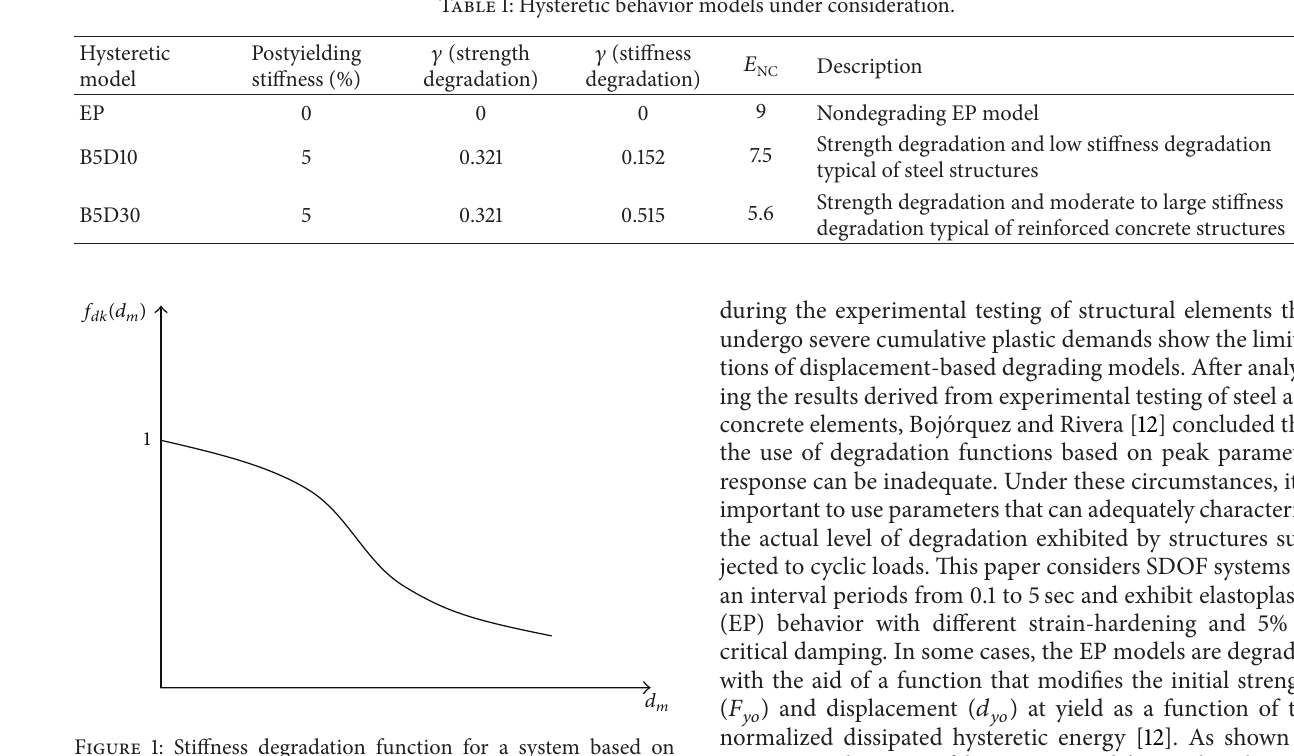
Table 1: Hysteretic behavior models under consideration.